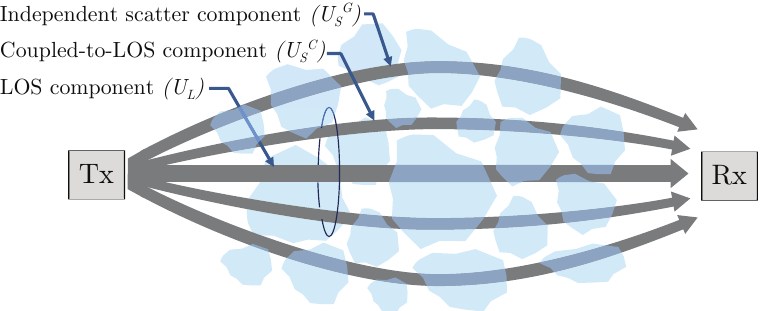
Figure 2. Laser beam propagation scheme under an M -distributed FSO link